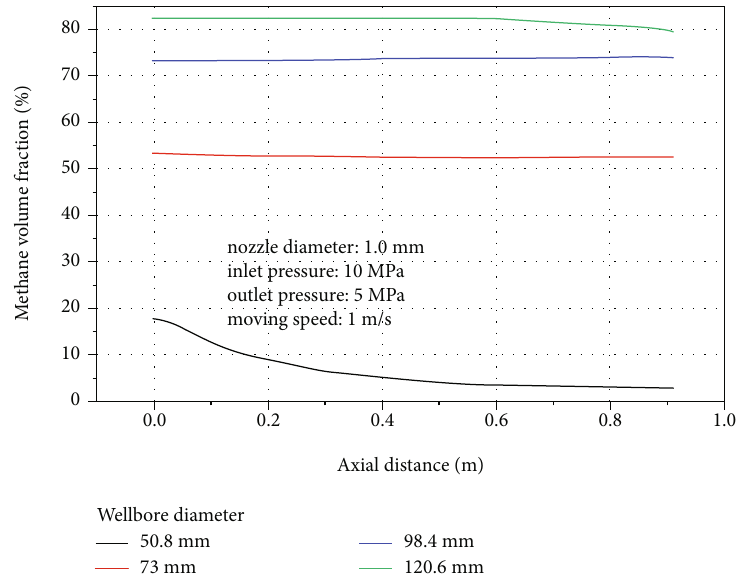
Figure 7: The e ff ect of wellbore diameter on the distribution of methane components in wellbore.